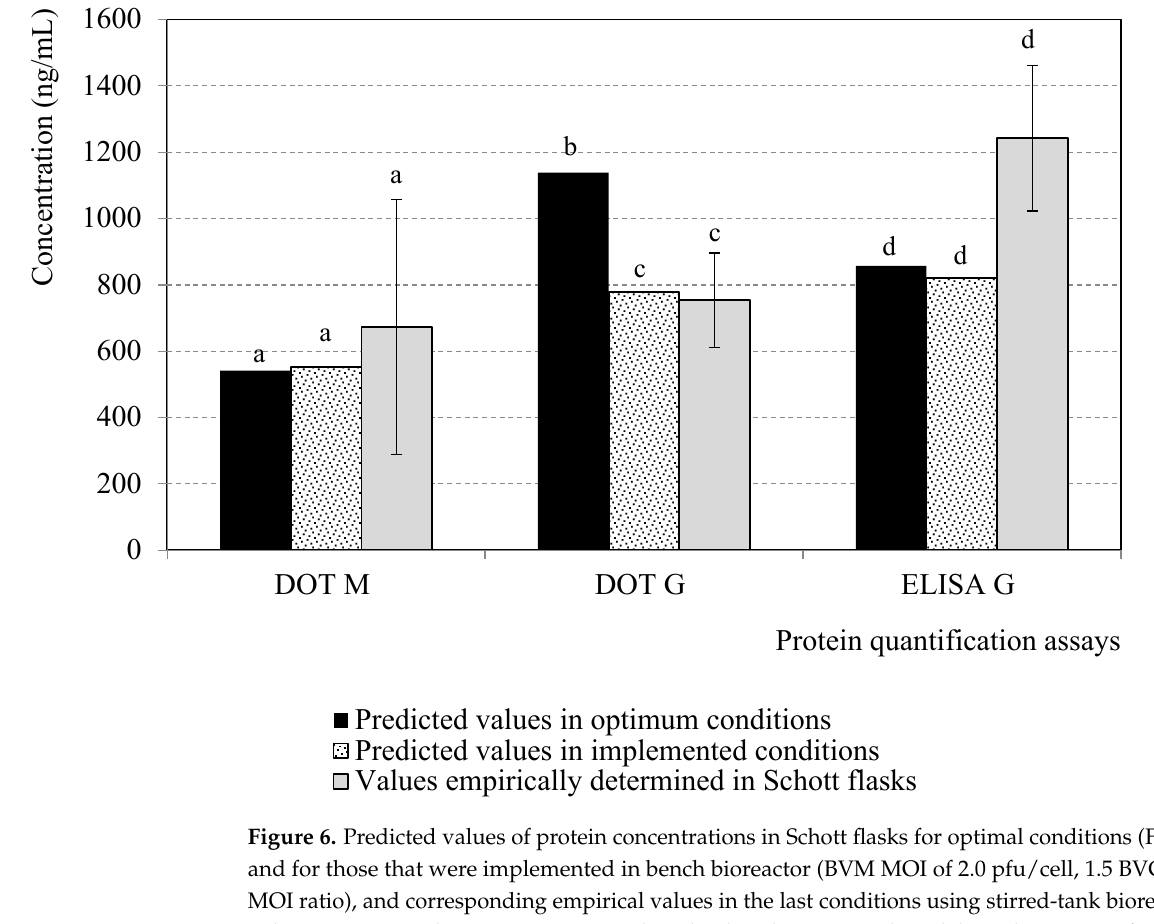
Figure 6. Predicted values of protein concentrations in Schott flasks for optimal conditions (Figure 5) and for those that were implemented in bench bioreactor (BVM MOI of 2.0 pfu/cell, 1.5 BVG/BVM MOI ratio), and corresponding empirical values in the last conditions using stirred-tank bioreactor as culture system. Columns represent predicted values by statistical models or the average from three experimental repetitions. Error bars depict the standard deviation from triplicate empirical runs. The letters represent statistically similar values for each protein concentration quantification technique.